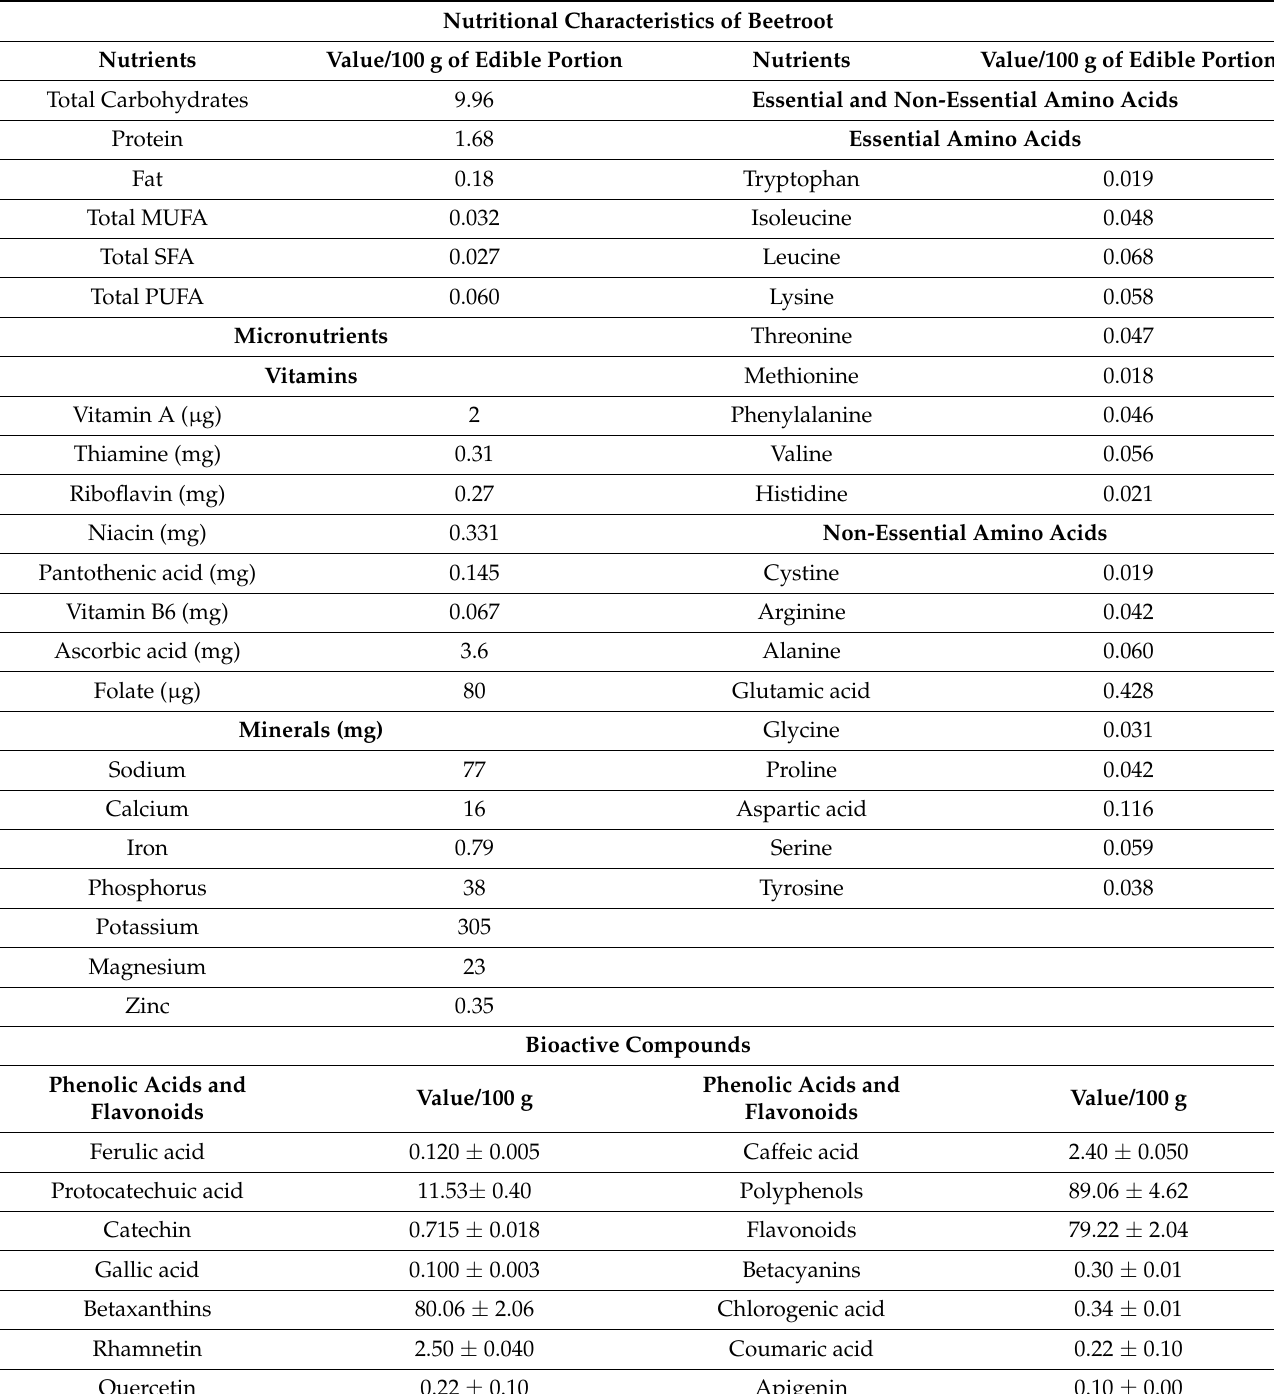
Table 1. Nutritional components of beetroot ( Beta vulgaris L.) [7–9]. g = gram, µ g = microgram, mg =